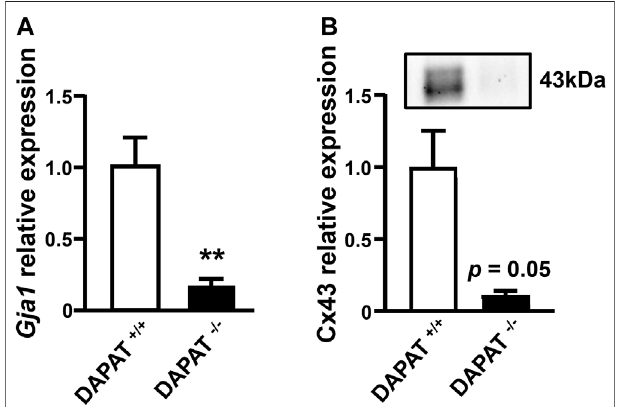
FIGURE 2 | Downregulation of Cx43 gene and protein expression in the retina of plasmalogen-de fi cient DAPAT adult mice. (A) RT-qPCR analysis of Gja1 expression shows a signi fi cant downregulation in 13 weeks-old plasmalogen-de fi cient DAPAT − /- mice retina compared to DAPAT +/+ miceretina(** p < 0.01;n=6 – 8). (B) Western-blotanalysisofCx43expression reveals a downregulation in 13 weeks-old plasmalogen-de fi cient DAPAT − /- mice retina compared to DAPAT +/+ retina ( p = 0.05; n = 3). Mann & Whitney test. Data shown as mean ± SEM.